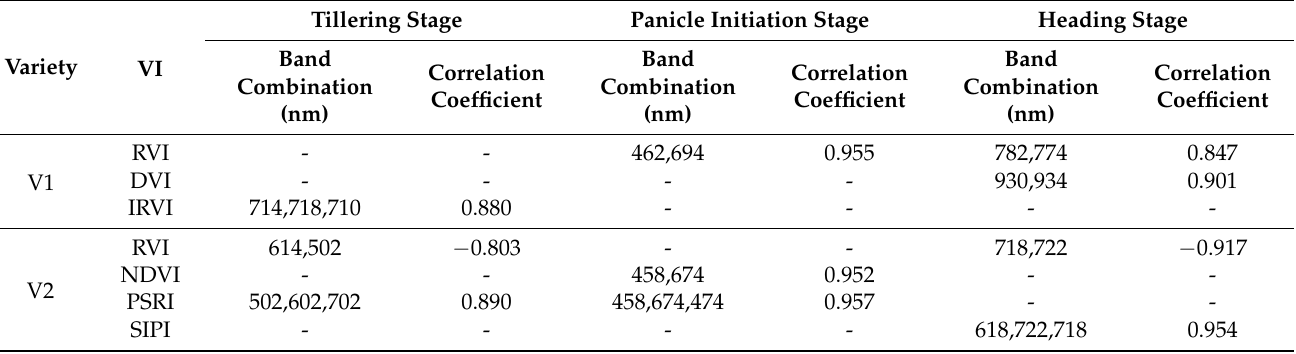
Table 3. Relationships between leaf area index (LAI) and the optimal spectral index of rice